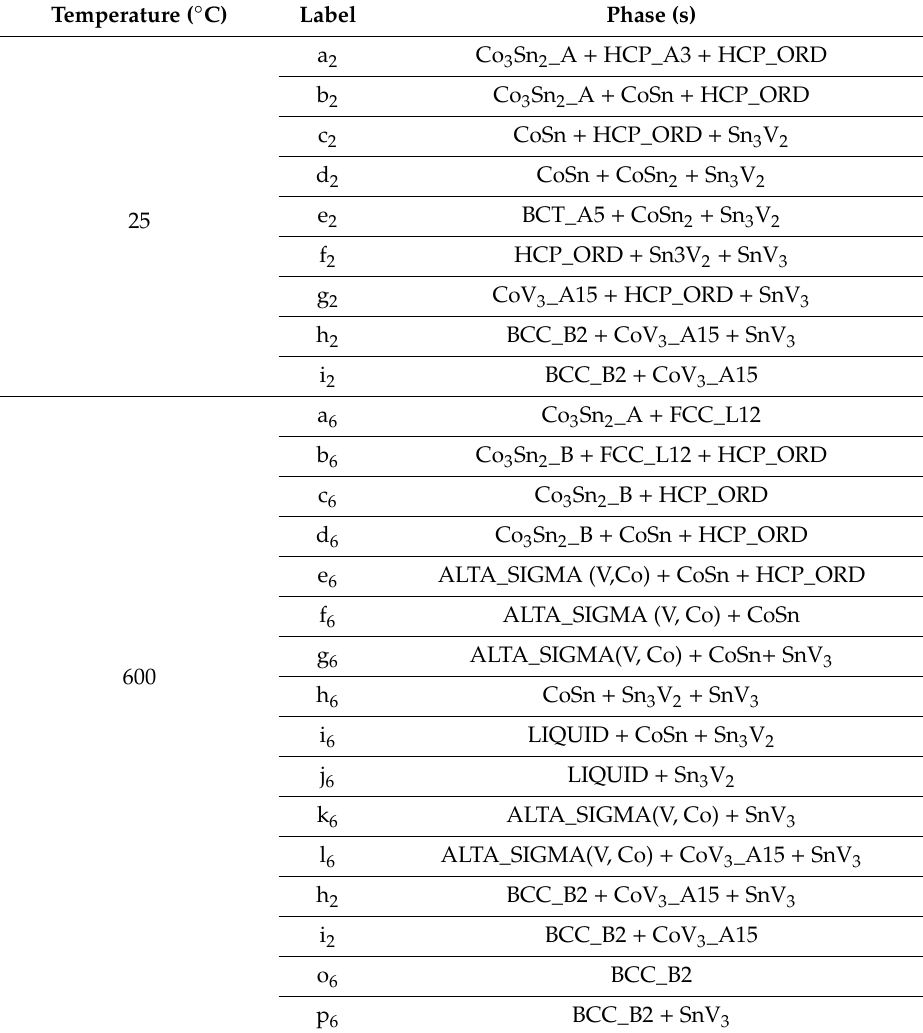
Table 2. Phase compositions of the nominated areas in Figure